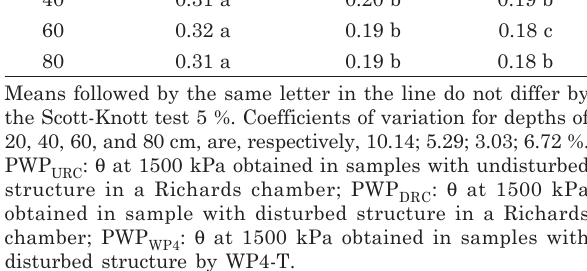
Table 8. Available water capacity (mm water/10